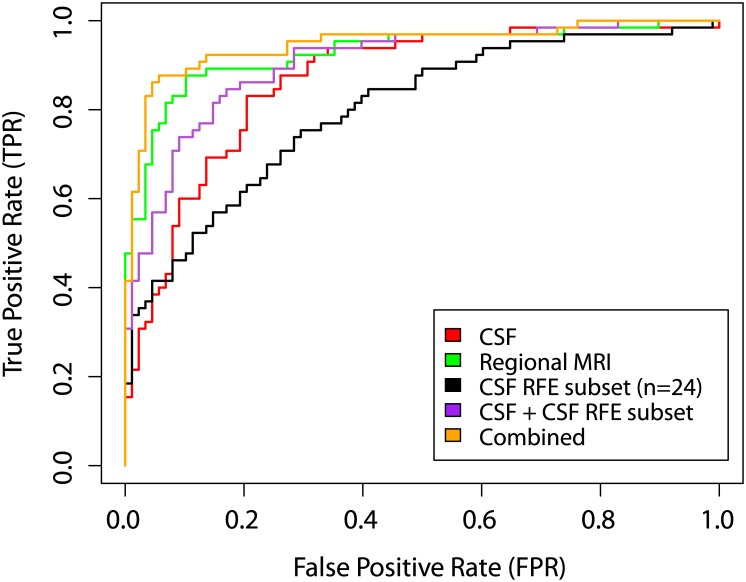
ROC curves from disease classification models for differentiating between AD and CN individuals.